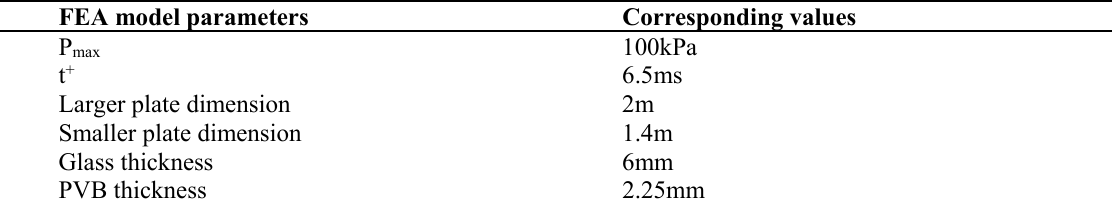
Table 2: parameters used in FEA model (1 plie approach) to generate Fig. 5a-c